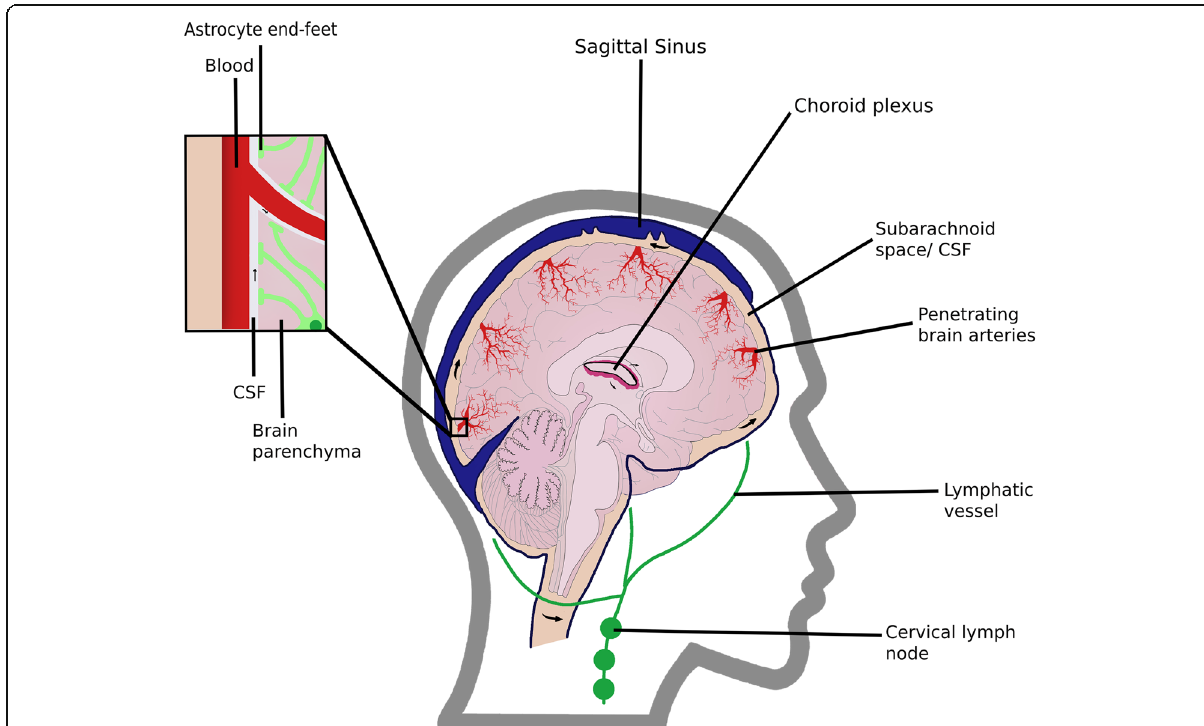
Fig. 1 Sagittal view of the glymphatic system, showing in detail the astrocytes and their end-feet. CSF flows from the Choroid plexus into the subarachnoid space, under the sagittal sinus. From there, it flows along the outside of brain arteries into the interstitium, mixing with ISF, and clearing the solutes present in the brain